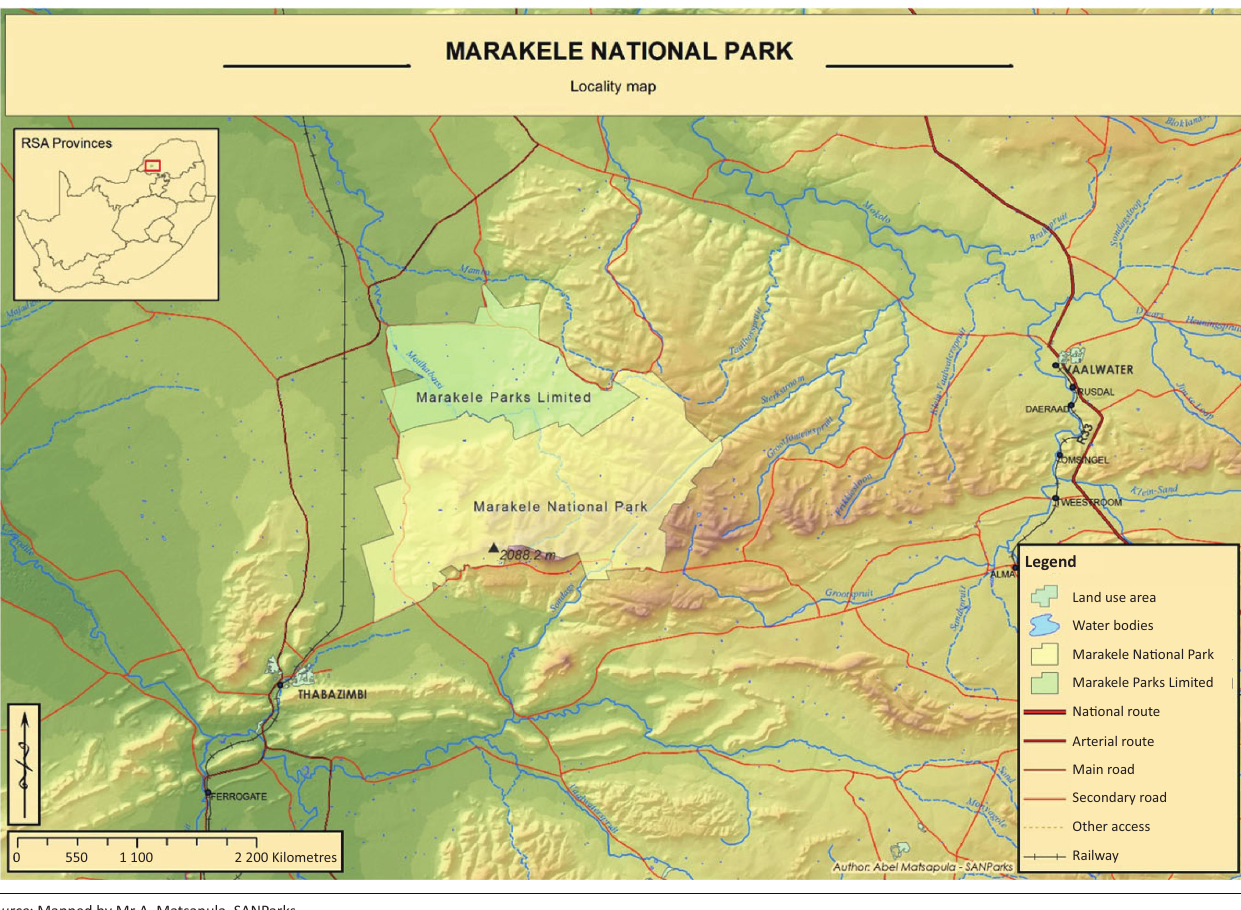
FIGURE 1: The location of the Marakele National Park.